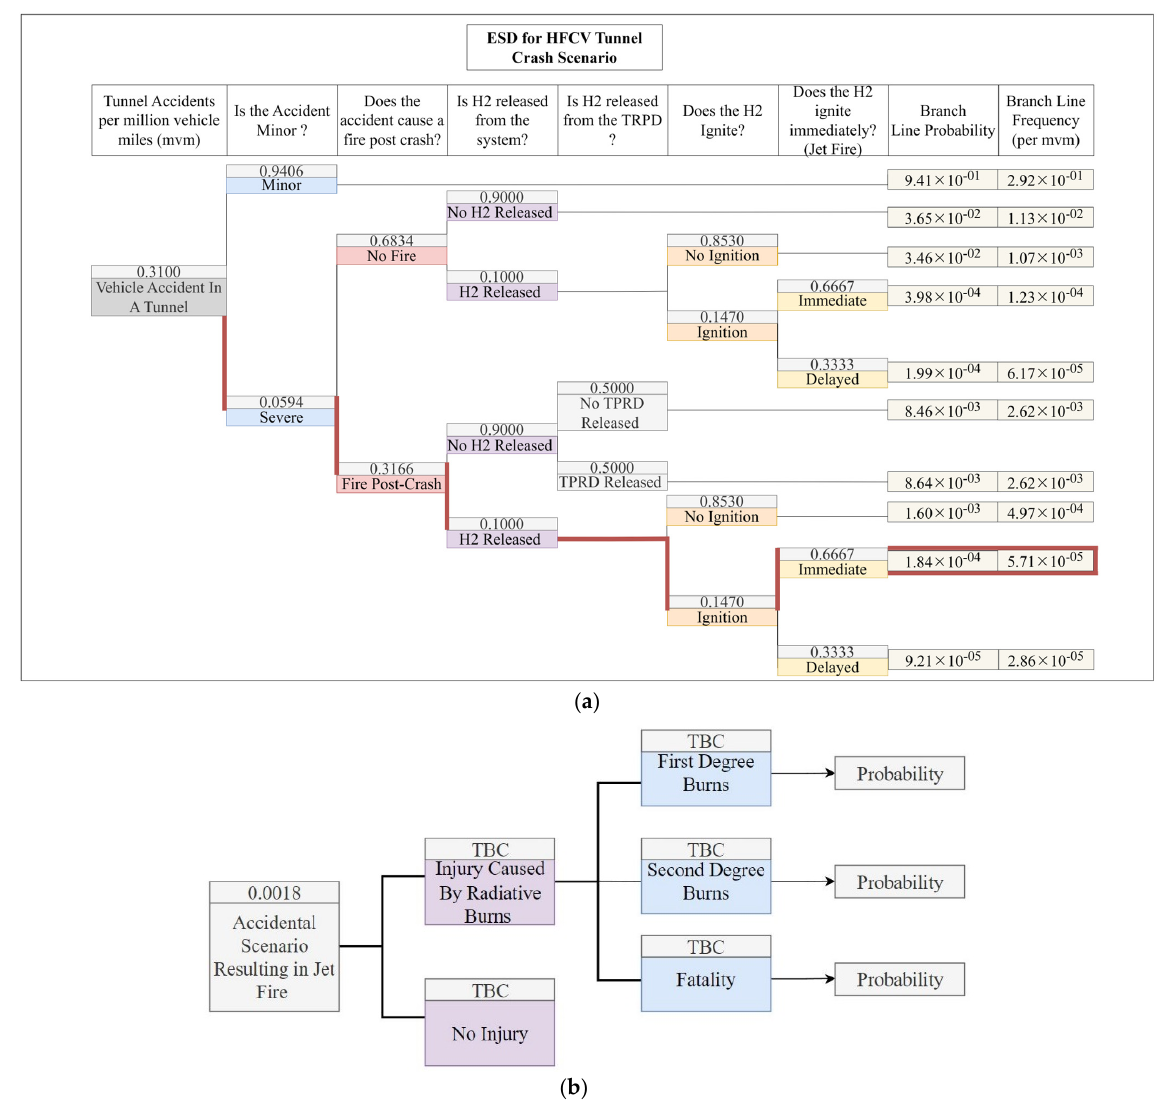
Figure 5. ( a ) ESD for HFCV Tunnel crash scenario [16] and ( b ) Thermal radiation burns probability ESD continuation. TBC—To Be